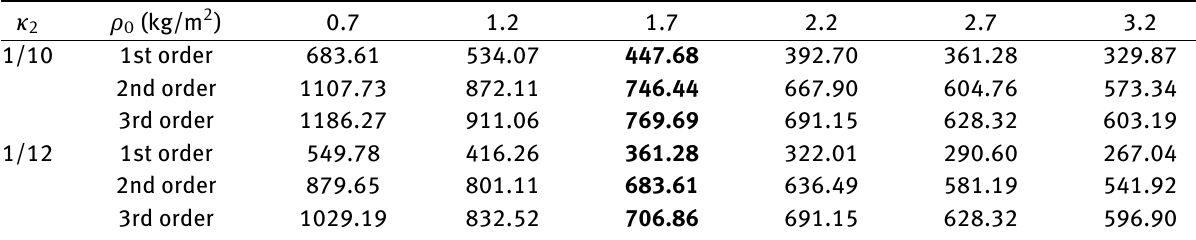
Table 9: The natural frequencies (rad/s) of numerical solutions under different material densities and rise span ratios κ